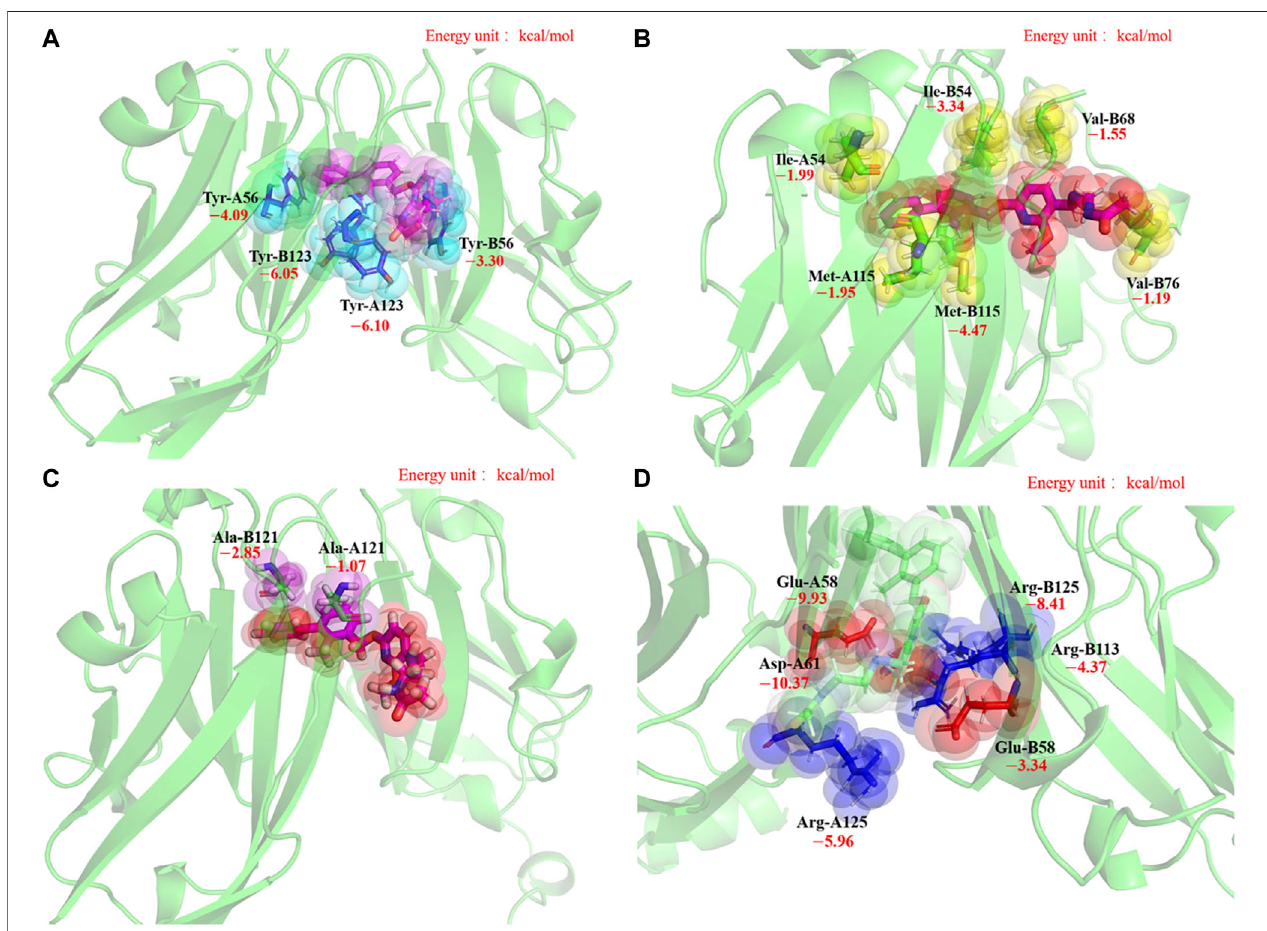
FIGURE 3 | The structures of four key residue groups of the MM-PBSA binding free energy decomposition in the 5J89 system. (A – D) represent the residue group 1, residue group 2, residue group 3 and residue group 4 respectively.